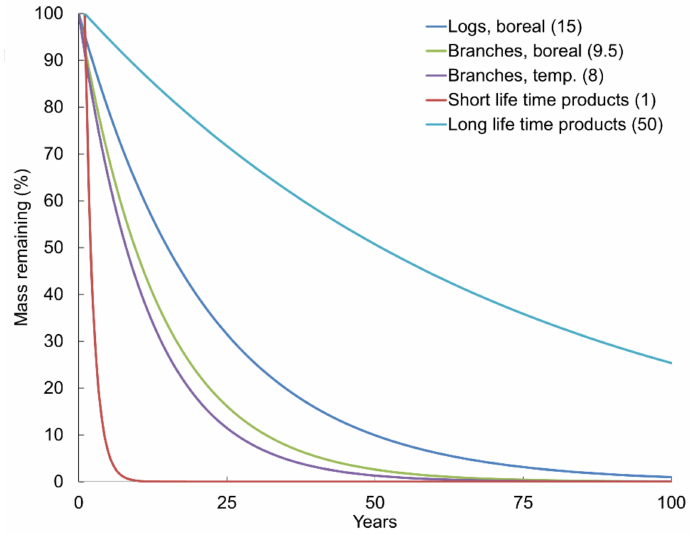
Figure 3. Decay rate of different biomass fractions and products for a 100-year period. Half-life periods in years are given in brackets.